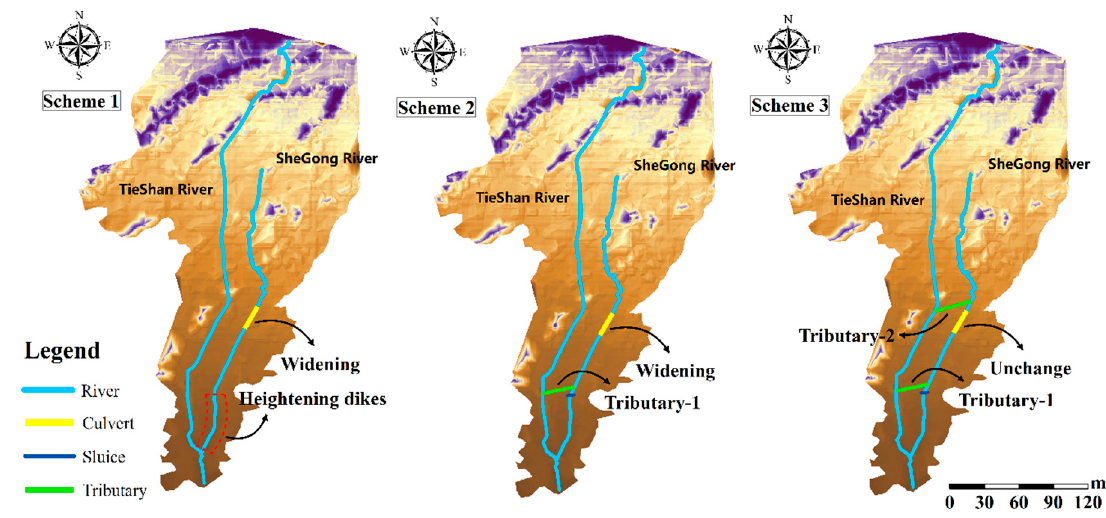
Figure 8. Schematic diagram of Scheme 2 and Scheme 3.